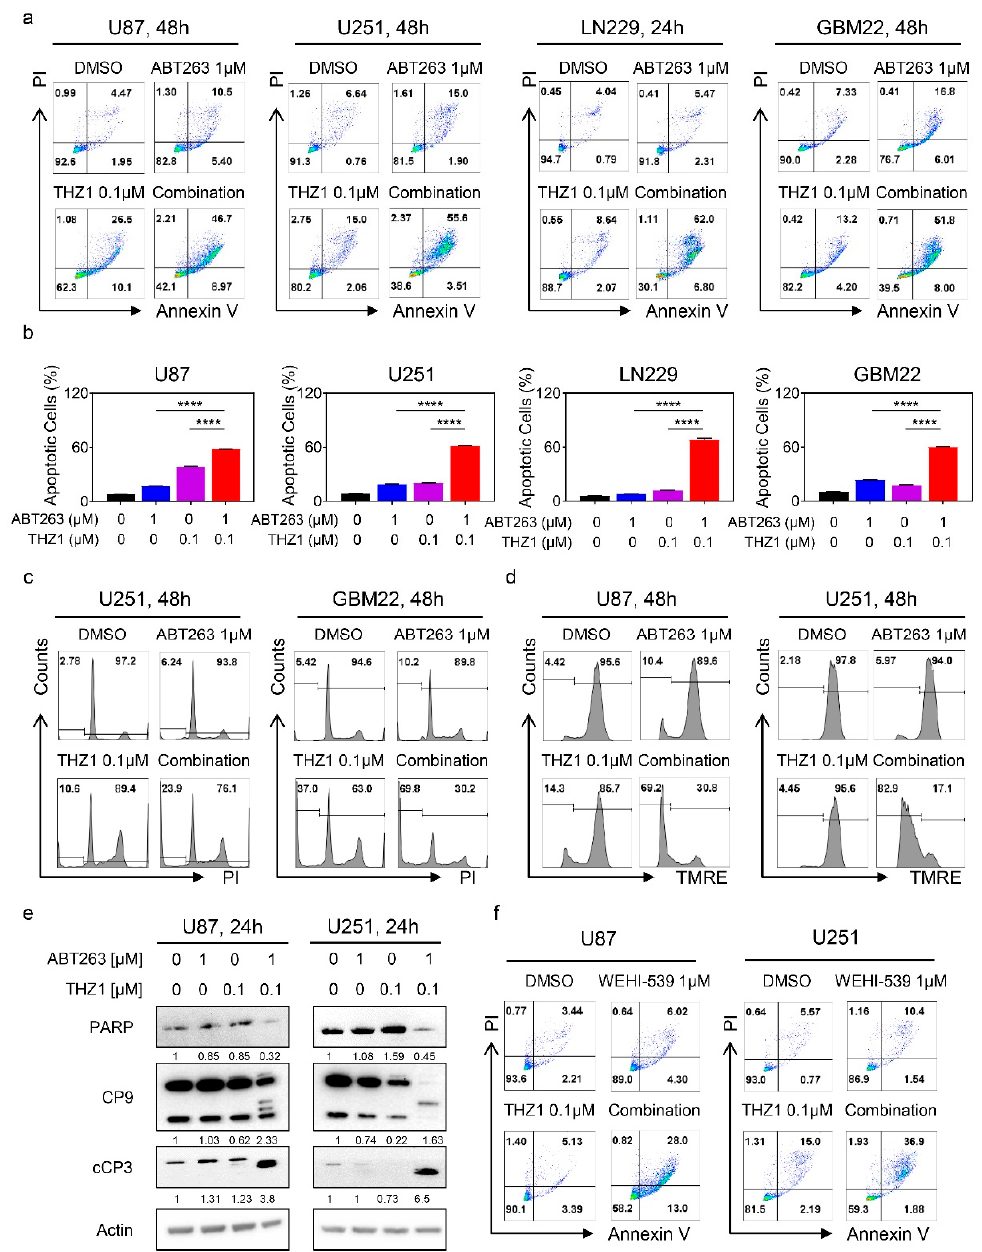
Figure 4. THZ1 and BH3-mimetics enhanced activation of a cell death with apoptotic features, including cleavage of initiator and effector caspases. ( a ) Representative flow plots of U87, U251, LN229, and GBM22 cells treated with ABT263, THZ1, or the combination of both for 24 h and labeled with Annexin / PI dye; ( b ) The graphs show apoptotic cells of U87, U251, LN229, and GBM22 cells treated with ABT263, THZ1, or the combination of both for 48h ( n = 3). Shown are means and SD. ANOVA was used for statistical analysis; ( c ) Representative flow plots of U251 and GBM22 cells treated with ABT263, THZ1, or the combination of both for 24 h, fixed and labeled with propidium iodide dye; ( d ) Representative flow plots of U87 and U251 cells treated with ABT263, THZ1, or a combination of both for 24 h and labeled with TMRE dye; ( e ) Standard western blots of cell lysates of U87 and U251 cells treated with ABT263, THZ1, or a combination of both for 24 h. Actin is used as a loading control. The protein expression levels of PARP, CP9, and cCP3 were quantified using ImageJ (shown in cursive font). Uncropped blots are shown in Figure S10; ( f ) Representative flow plots of U87 and U251 cells treated with WEHI-539, THZ1, or the combination of both for 24 h and labeled with Annexin / PI dye. **** p < 0.001.